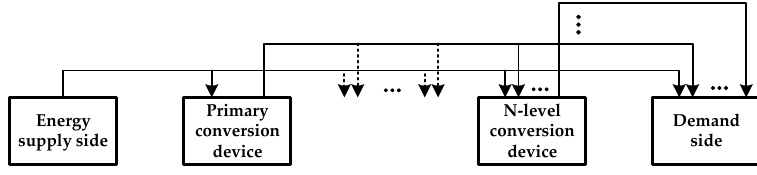
Figure 4. Energy-flow diagram of a complex energy-conversion interface.